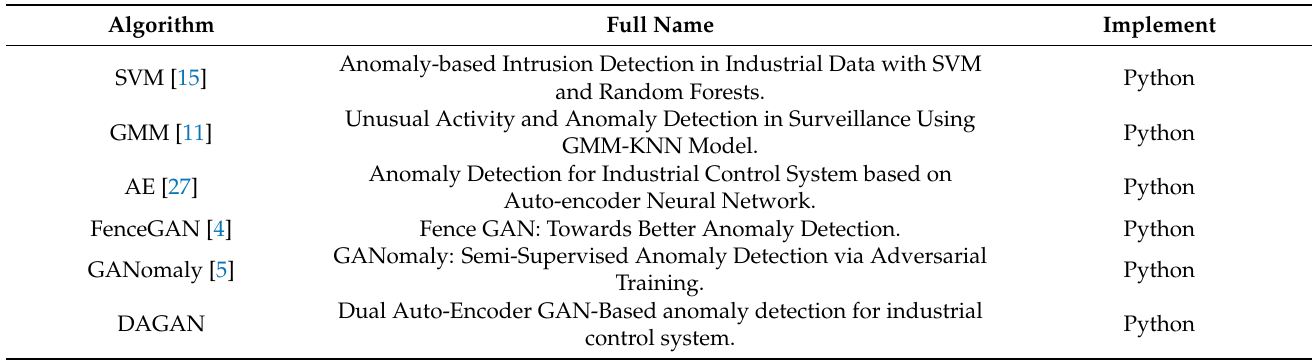
Table 1. Comparison